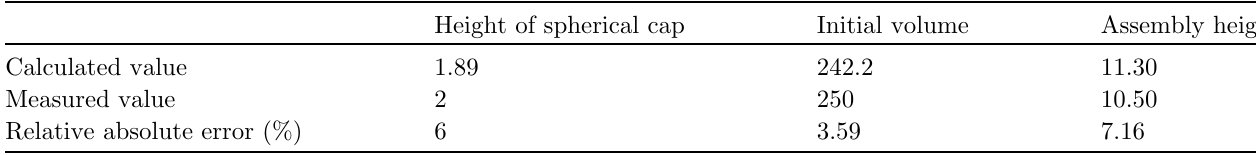
Table 7. Calculated and measured values of air spring geometric parameters.